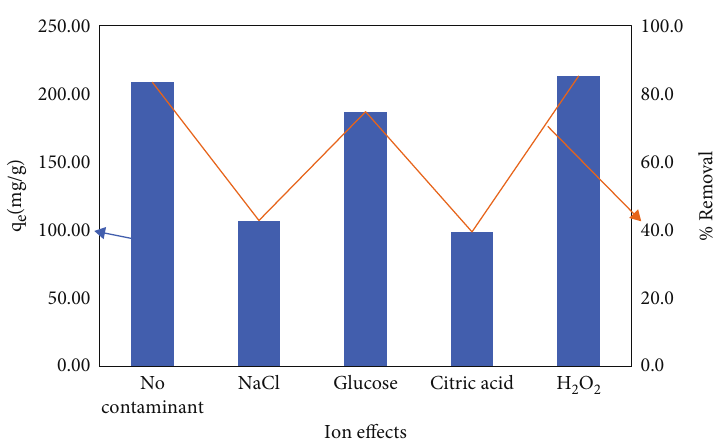
Figure 8: Ion e ff ects on MB adsorption capacity and removal percentage.